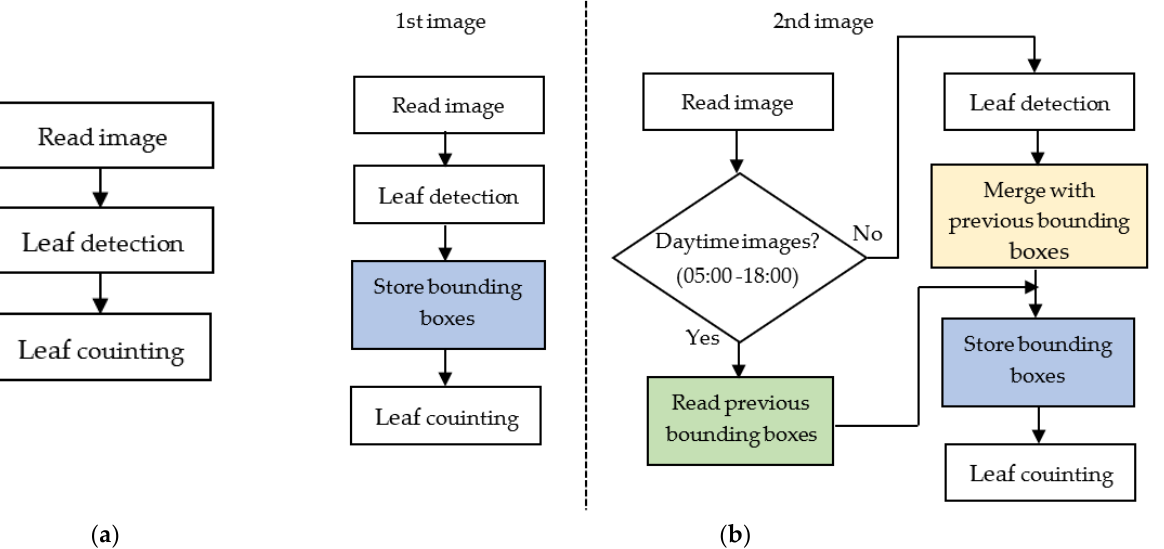
Figure 4. Flowchart of proposed systems: ( a ) static image approach; ( b ) image sequence approach.